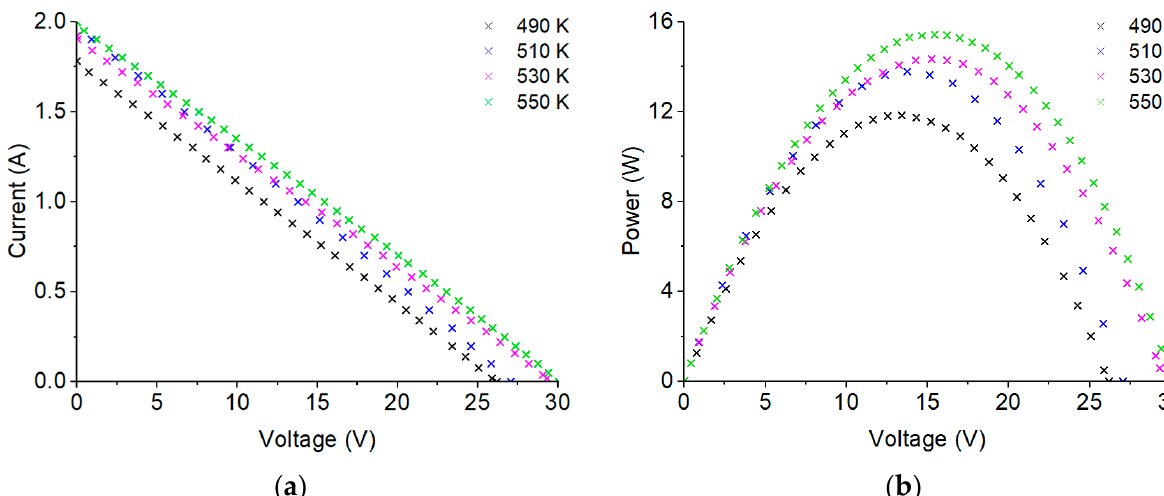
Figure 14. I-V ( a ) and P-V ( b ) characteristics of the tested TEG No. 5. Figure 14. I–V ( a ) and P–V ( b ) characteristics of the tested TEG No.